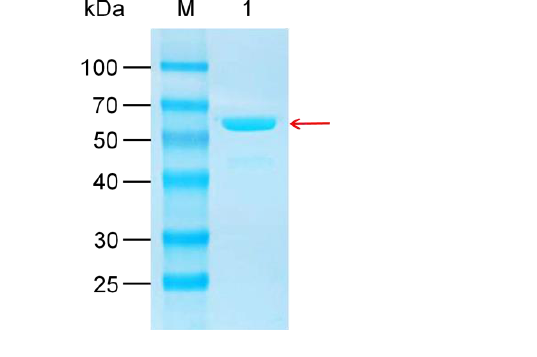
Figure 1. SDS-PAGE analysis of the recombinant UGT109A1 expressed in Escherichia coli . M: Molecular weight marker; 1: The recombinant UGT109A1 purified by Ni-NTA affinity chromatography.